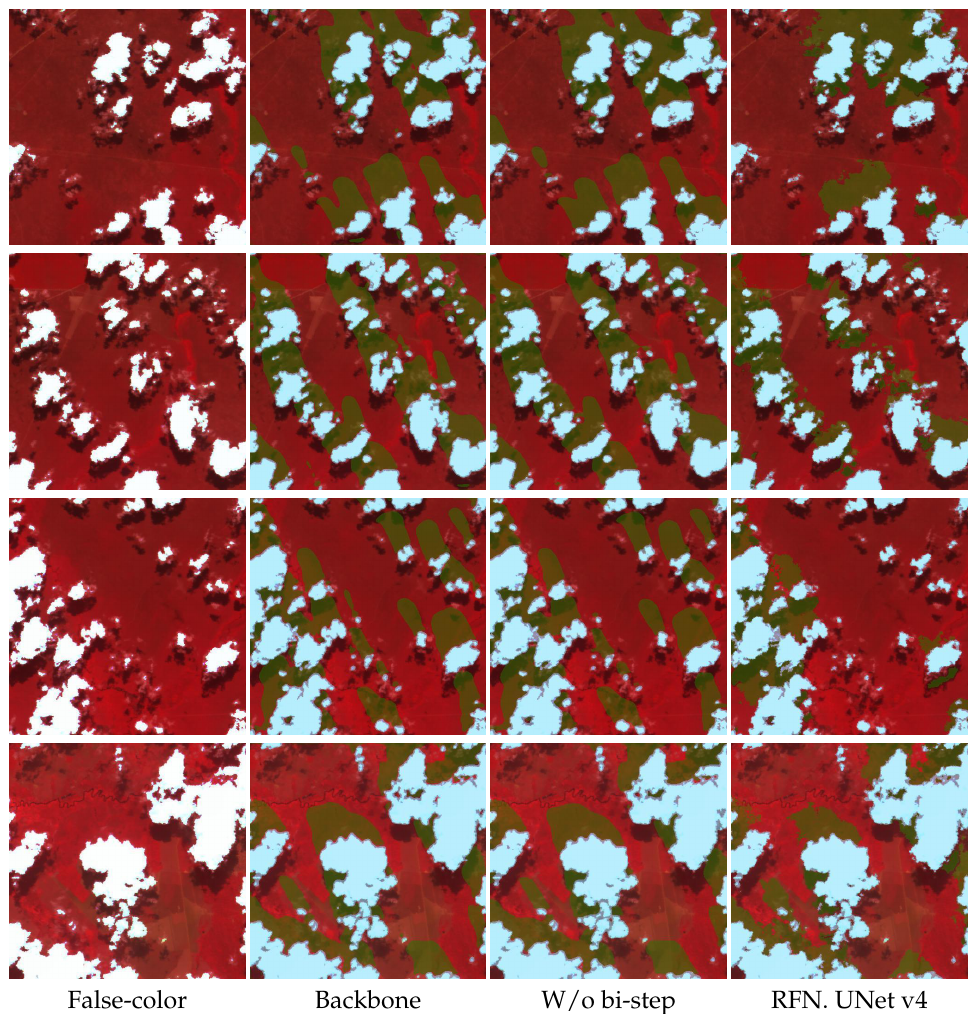
False-color Backbone W/o bi-step RFN. UNet v4 Figure 7. Illustrations of the effects of the critical modules